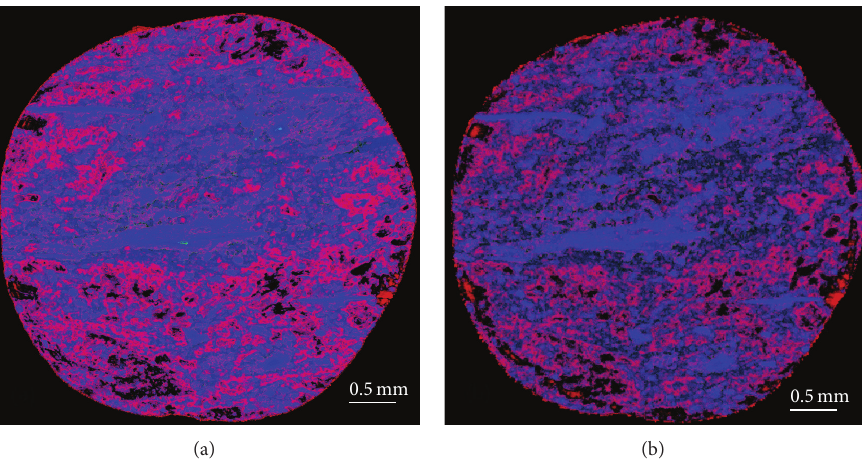
Figure 3: DCM reconstructed compositional distributions: (a) at resolution of 3.7 𝜇 m; (b) at resolution of 11.84 𝜇 m. Pores are displayed as red; group C minerals are displayed as blue; group D minerals are displayed as green. The pixel display intensity for each colour is proportional to the appropriate compositional volume fraction. Coexistence of multiple compositions in a voxel is shown as colour mixing. The coal matrix is not displayed.